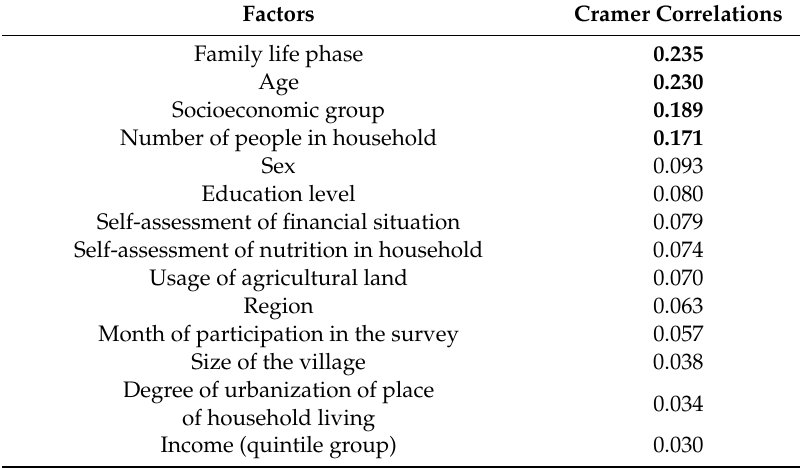
Table 2. Dependence of cluster analysis on sociodemographic and economic factors of the